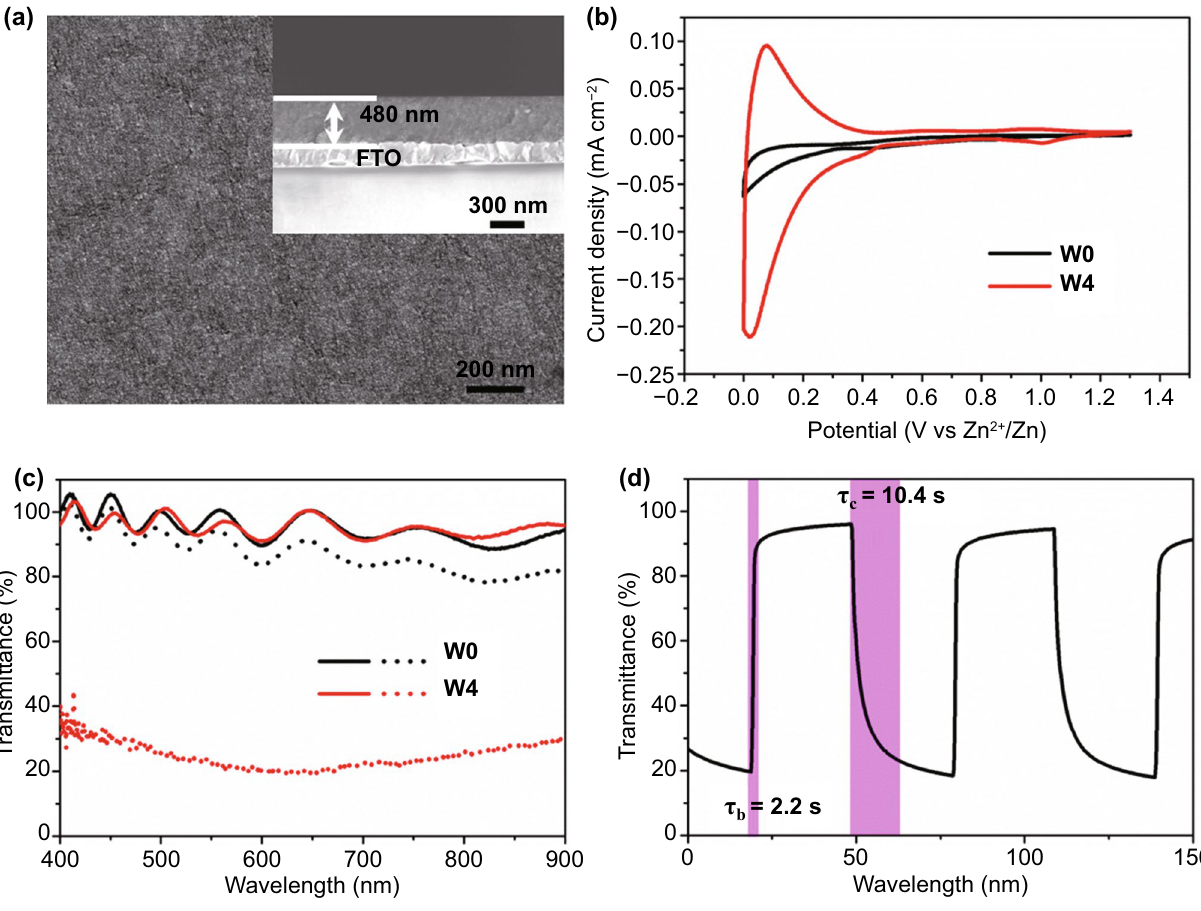
Fig. 2 Characterizations of W-doped TiO 2 NC films. a Surface and cross-sectional (inset) SEM images of a W4 film. b Voltammograms of the TiO 2 and W4 NC films at 1 mV s −1 in the 0–1.3 V (vs. Zn 2+ /Zn) window in 1 M ZnSO 4 aqueous electrolyte. c Optical transmittance spectra of the TiO 2 and W4 NC films at fully colored (dot lines) and bleached (solid lines) states. d In situ optical transmittance of a W4 NC film at 550 nm in potential steps of 0–1.3